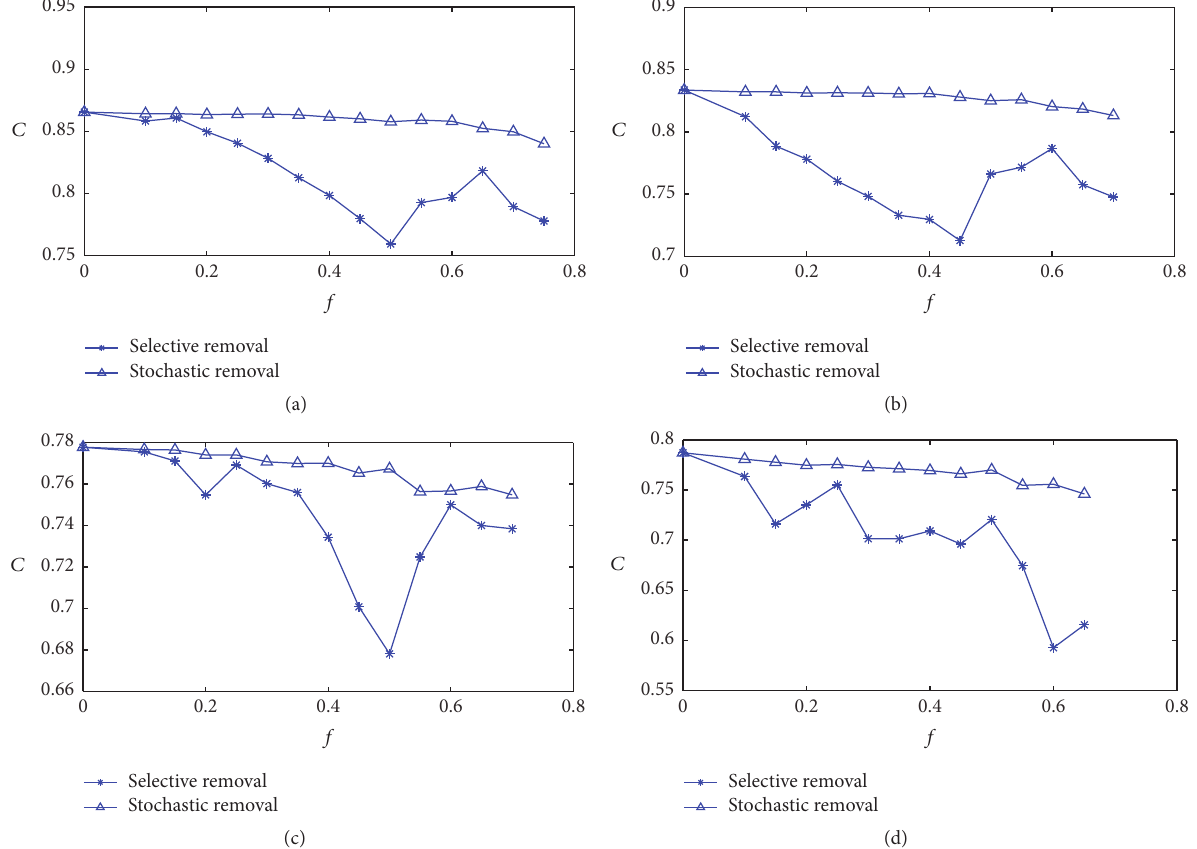
Figure 8: The clustering coefficient 𝐶 versus 𝑓 when (a) 𝜃 = 0.25 ; (b) 𝜃 = 0.3 ; (c) 𝜃 = 0.35 ; (d) 𝜃 = 0.4 . With an increase of 𝑓 , we find that the network becomes more and more weak to selective removal and is always robust against stochastic removal. If the thresholds equal other values in interval [0.25, 0.4], the general rules of topological stability are not changed. So we only demonstrate aforesaid four cases.